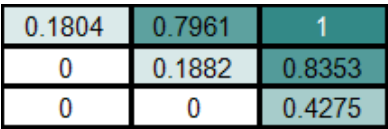
Figure 6. Group of obtained cells G .